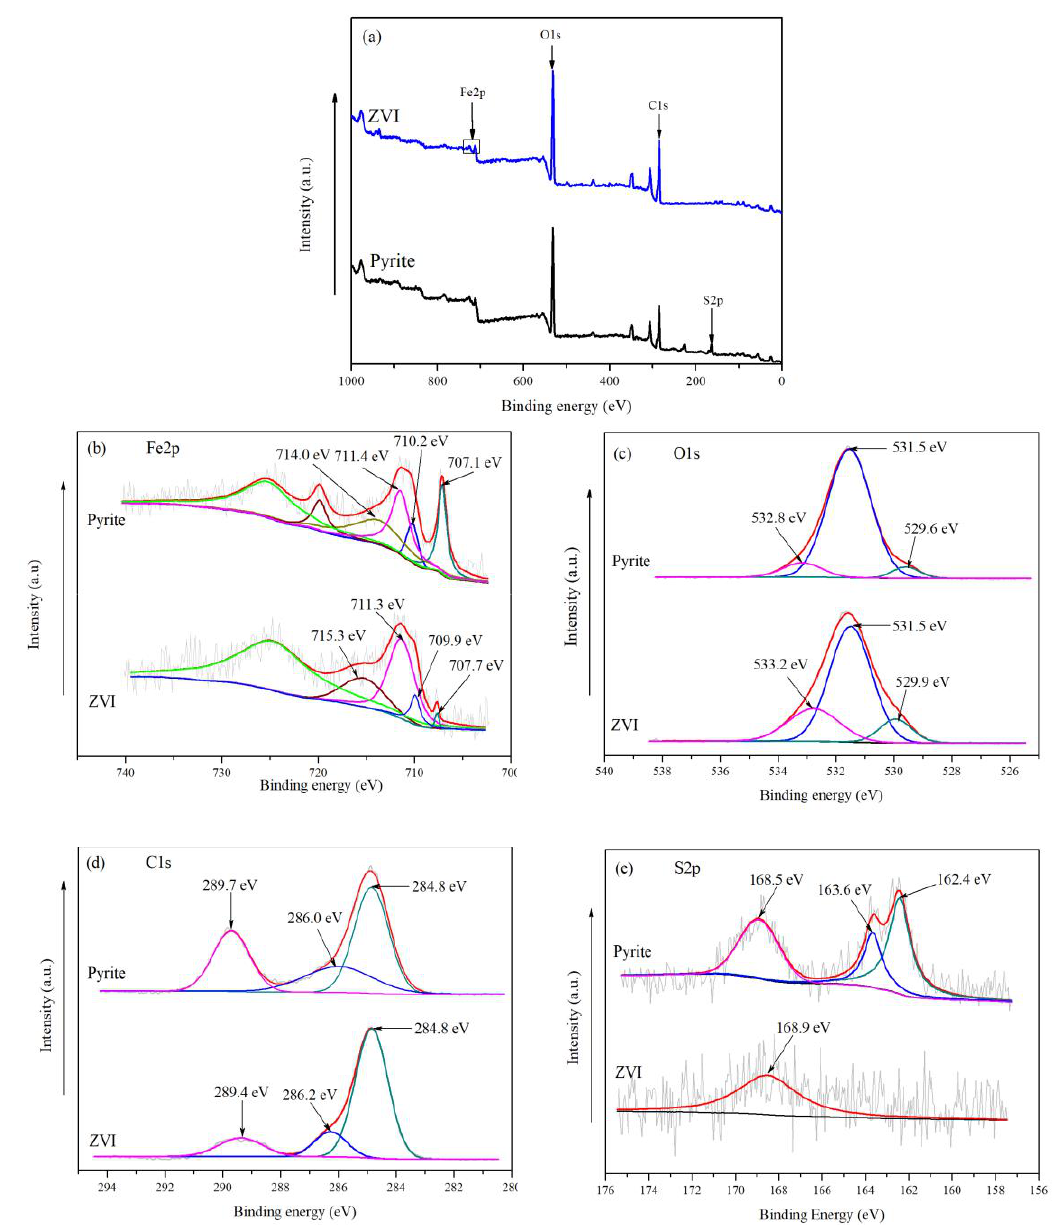
Figure 7. XPS spectra of ZVI and pyrite surface layer after the reaction. ( a ) full-range scan of the samples, ( b ) Fe2p spectra, ( c ) O1s spectra, ( d ) C1s spectra, ( e ) S2p spectra.